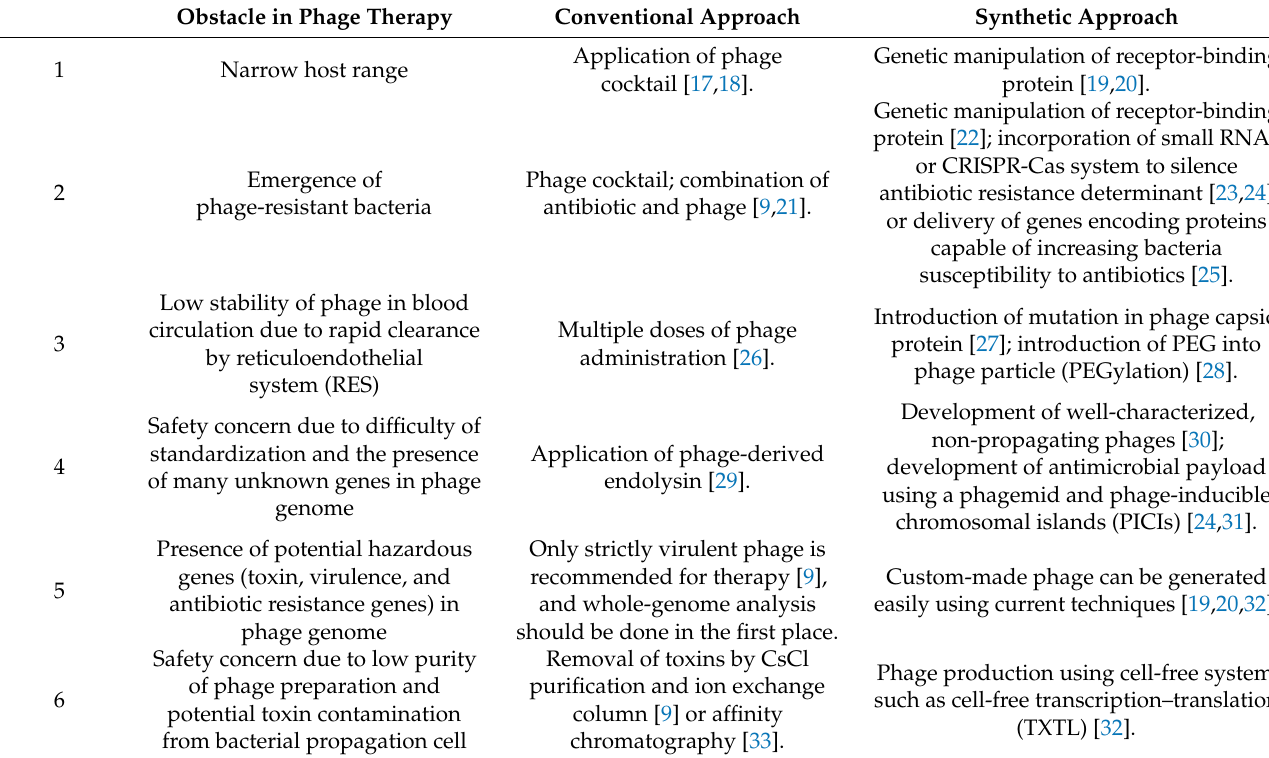
Table 1. Obstacles in phage therapy and emerging approaches in synthetic